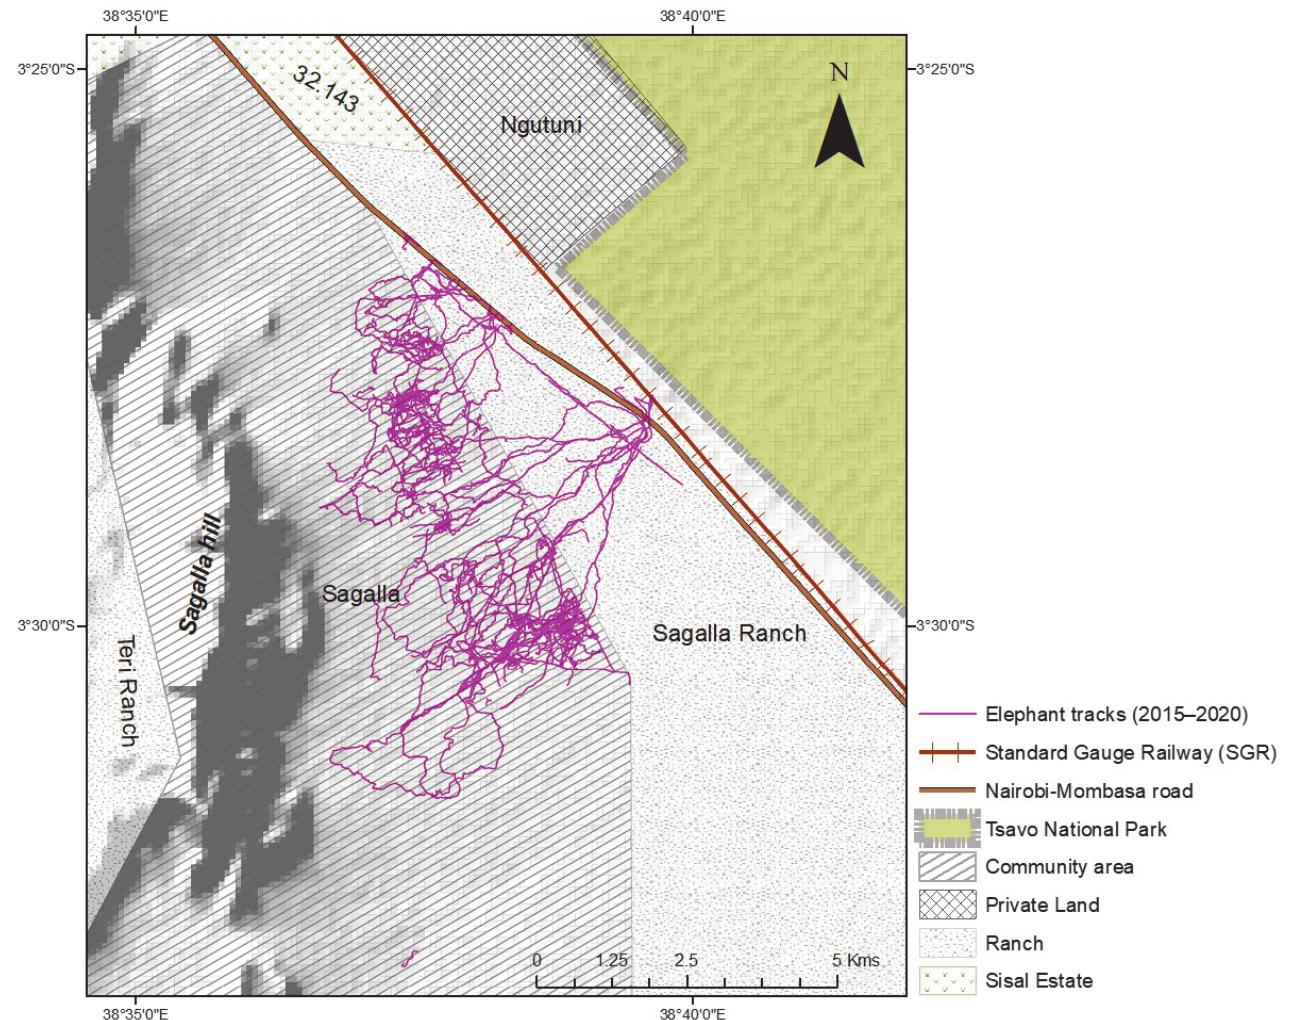
Figure 3. This illustration shows the 268 elephant movement tracks collected using the hand-held GPS across the landscape within the Sagalla area, most of which is still naturally vegetated. They are a depiction of the exact footprint locations as they moved from one point to